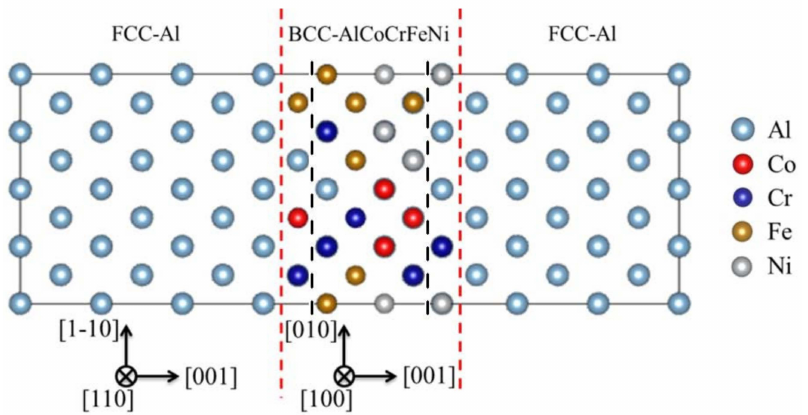
Figure 1. Typical configuration of supercell used for the calculations of HEA-reinforced AMCs; the red dash lines represent the interfaces between f.c.c-Al and the b.c.c-AlCoCrFeNi HEA. The interfacial regions are defined as those between the red and black dash lines.